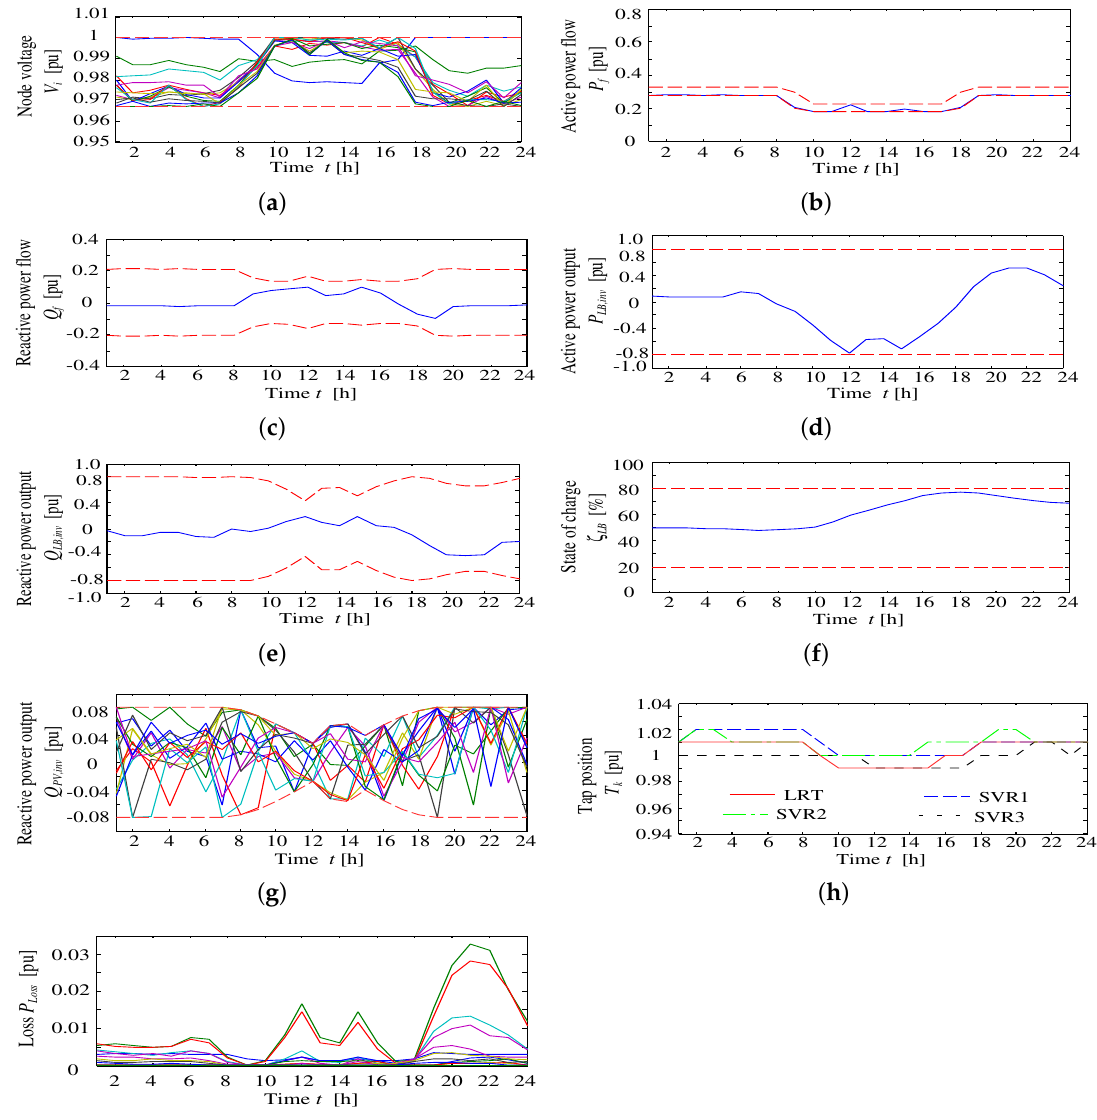
Figure 11. Simulation results of proposed method (Case 4). ( a ) Voltage profile without control, ( b ) active power flow at the interconnection point and ( c ) reactive power flow at the interconnection point. ( d ) Active power output of large BESS. ( e ) Reactive power output of large BESS. ( f ) SOC of large BESS. ( g ) Reactive power compensation from the interfaced inverter of the end users. ( h ) Tap position of OLTCs (LRT and SVRs). ( i ) Distribution losses of each node over time.